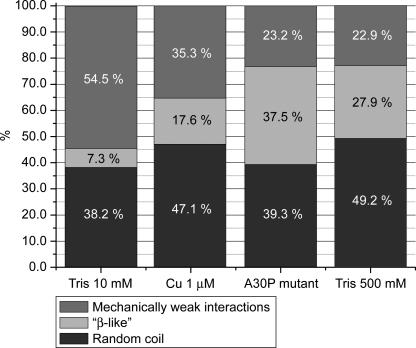
Population Shift of αSyn Conformers in Different ConditionsPopulation of αSyn conformers in the four different conditions tested in the present work. Percentages observed for each curve type (see Figure 1) at 10 mM Tris/HCl (n = 55), 10 mM Tris/HCl with 1 μM Cu2+ (n = 34), the A30P mutant in 10 mM Tris/HCl (n = 56), and 500 mM Tris/HCl (n = 61).